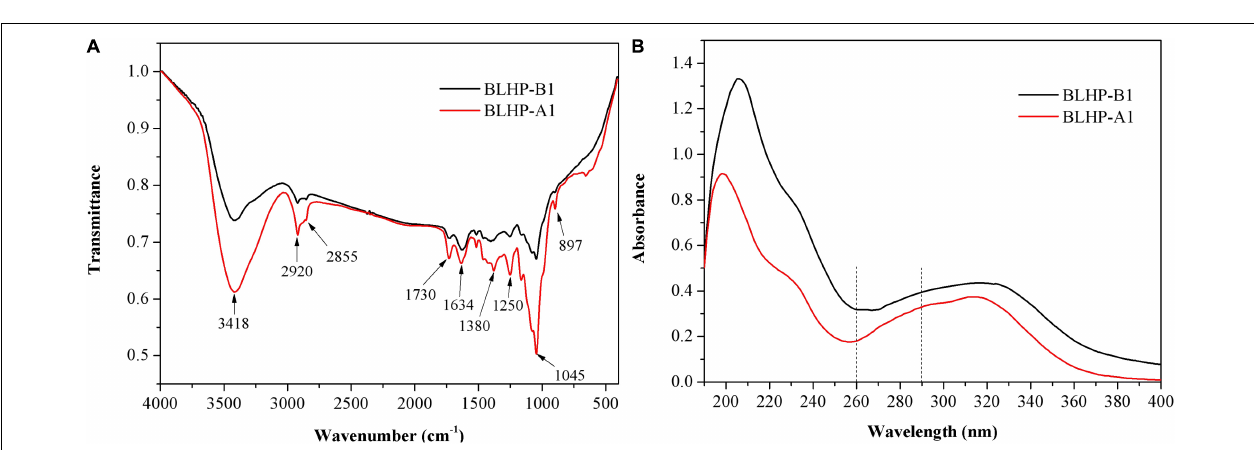
Frontiers in Nutrition |